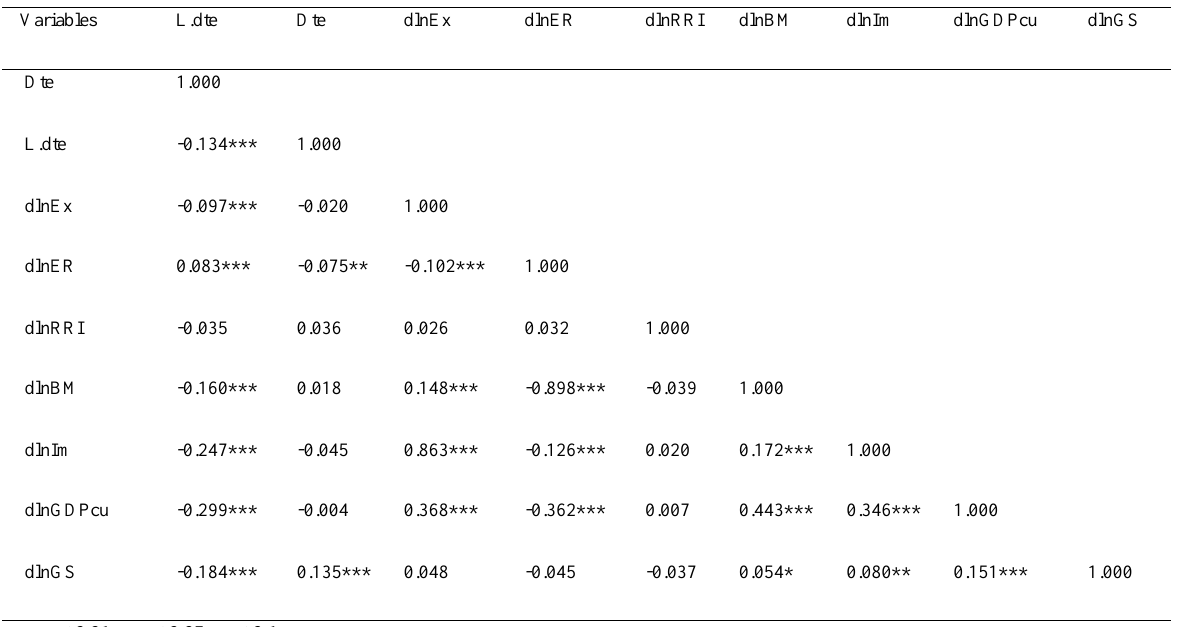
Table 7: Pairwise correlations matrix for Wealth Maximization with GDPppp covariate (significant variables with less than 90% correlation